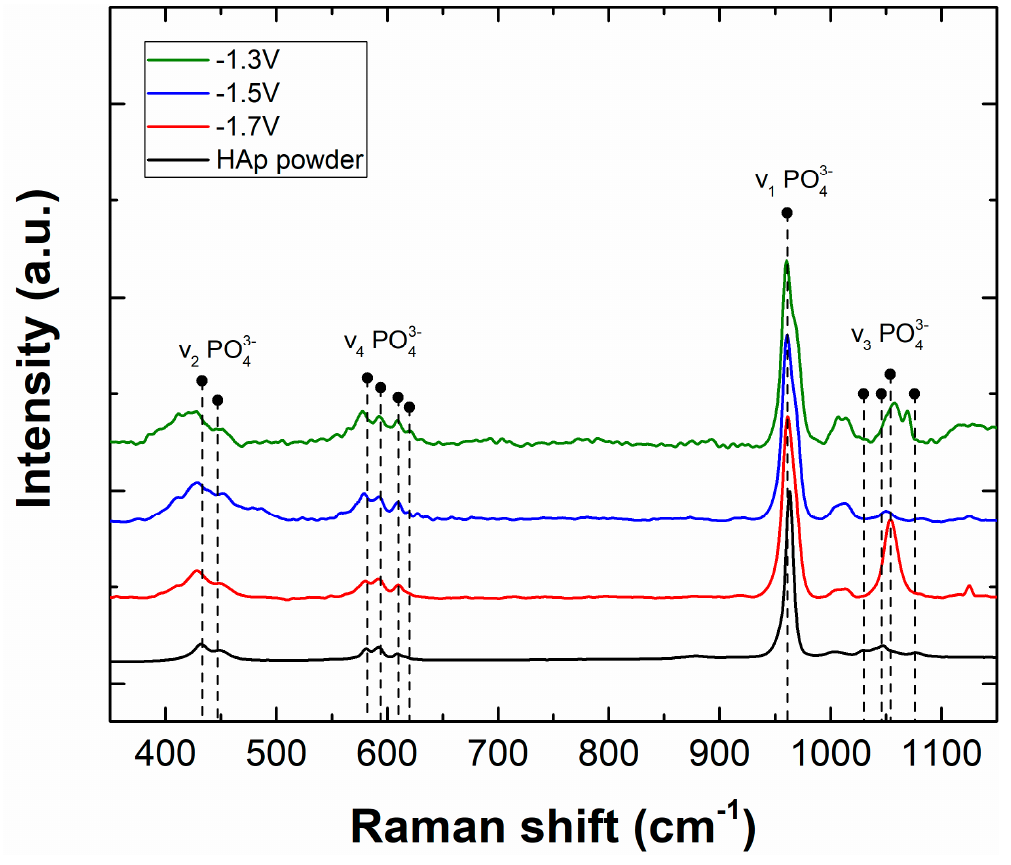
Figure 4. Raman spectra of HAp powders and HAp coatings deposited onto SS 3D-woven lattices under different electrodeposition potentials.